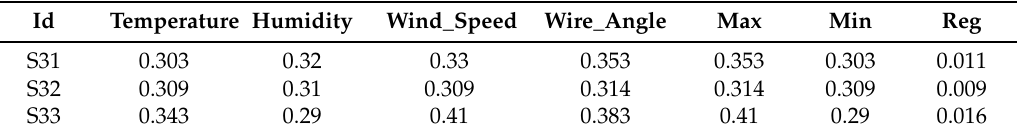
Table 6. S 3 .TB-qdatas table.